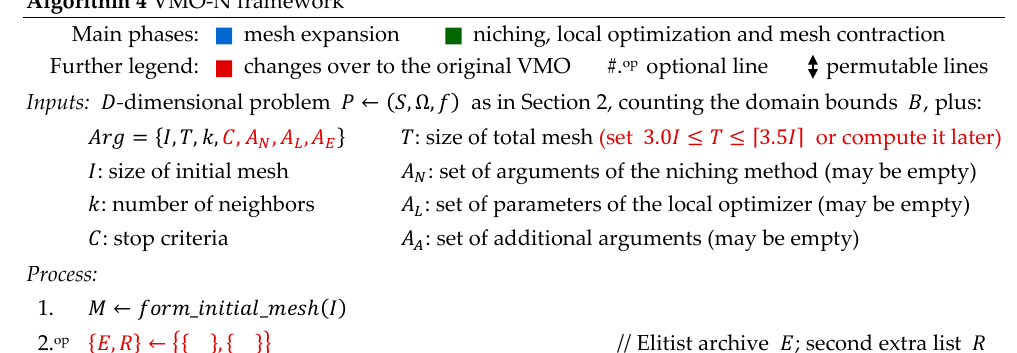
Algorithm 4 VMO-N